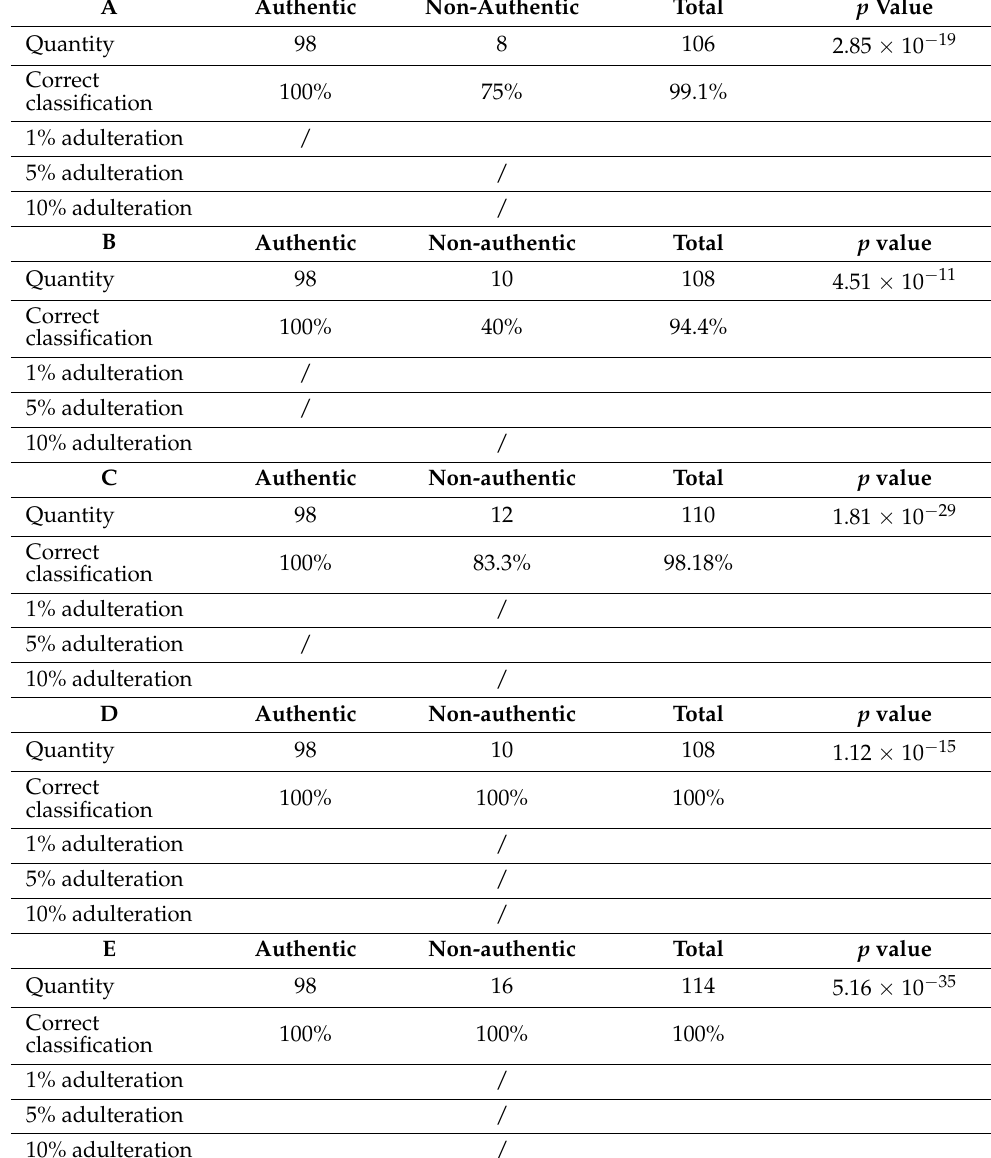
Table 4. Misclassification tables from a two-class OPLS-DA model applied to a prediction set of authentic and non-authentic EBNs using VIS/SW-NIR spectra (A: melamine, B: karaya gum, C: gelatine, D: collagen and E: nutrient agar). In the first row, the first column is the classes of the model, and the last column is the p value (<0.05) which represents the significance of the classification model. The second and third column is the total number of samples in each class and their respective individual number of correct classifications. The last three rows indicate the correct classification of adulterated EBNs into non-authentic EBNs or into incorrect classification of authentic EBNs